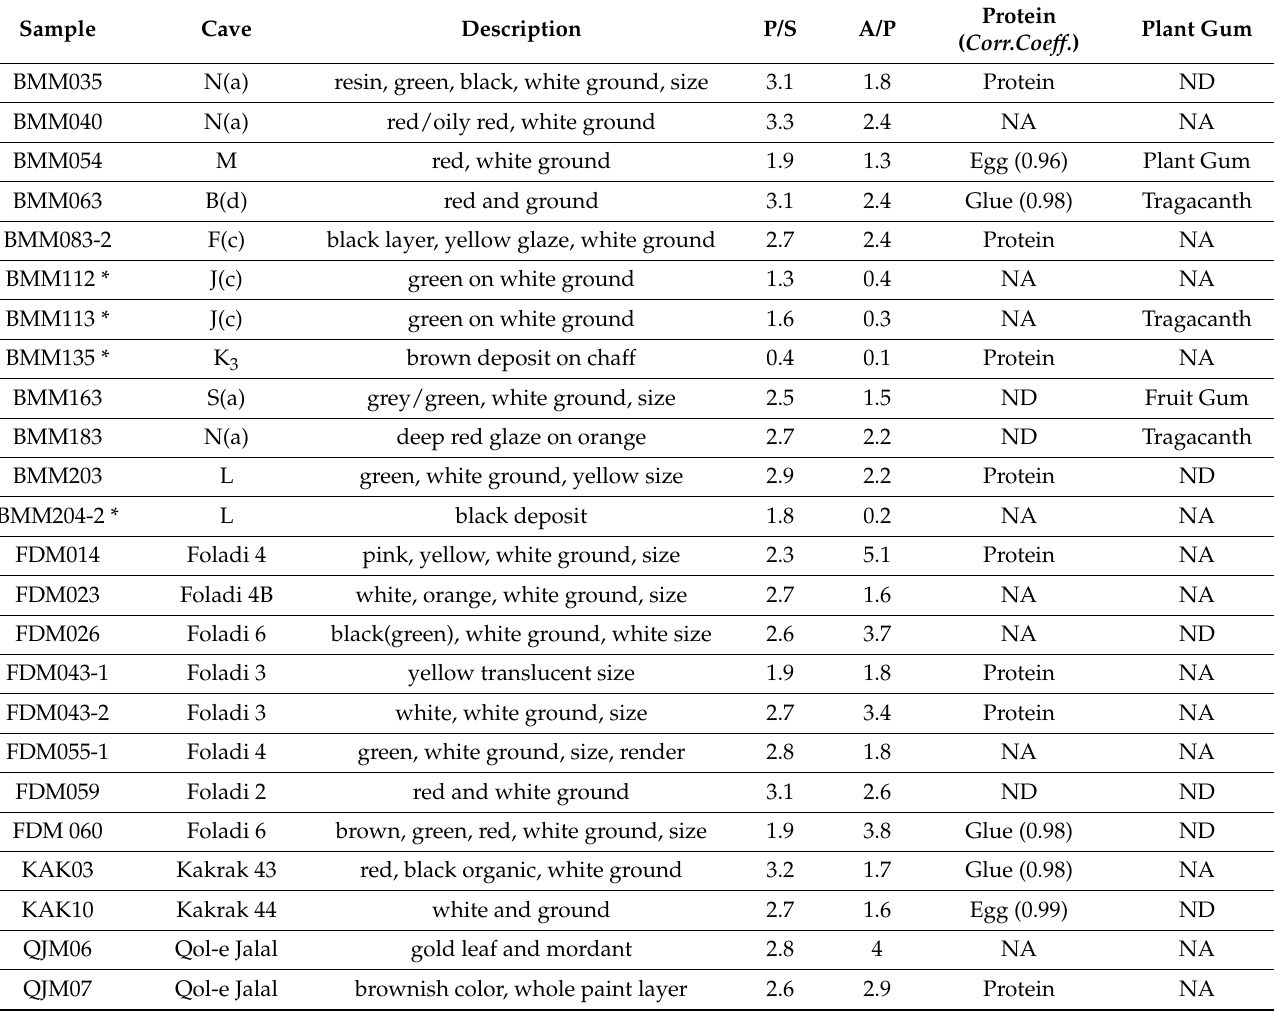
Table 4. Summary of GC-MS results for samples with oil. Samples are considered drying oil if the A/P ratio is greater than 1. Oils with A/P ratios lower than 0.6 (*) should be semi- or non-drying oils, fats, or lipids. NA = not analyzed, ND = not detected, below detection limit. Corr.coeff . = correlation